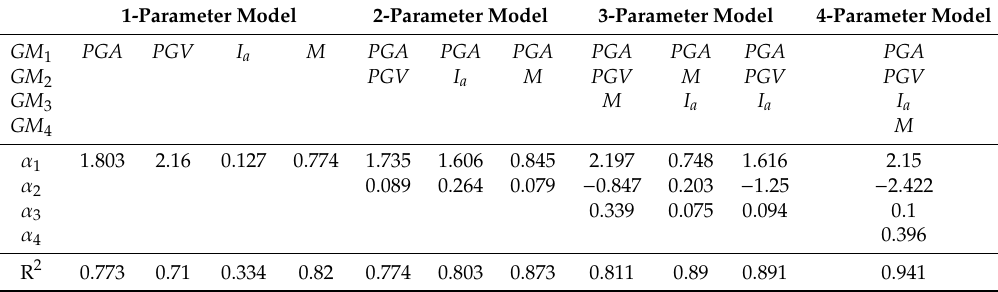
Figure 7. Crest settlement plotted against ground motion parameters. ( a ) PGA , ( b ) peak ground velocity ( PGV ), ( c ) moment magnitude ( M ), and ( d ) Arias Intensity ( I a ). Table 4. Coefficients for the crest settlement prediction model.